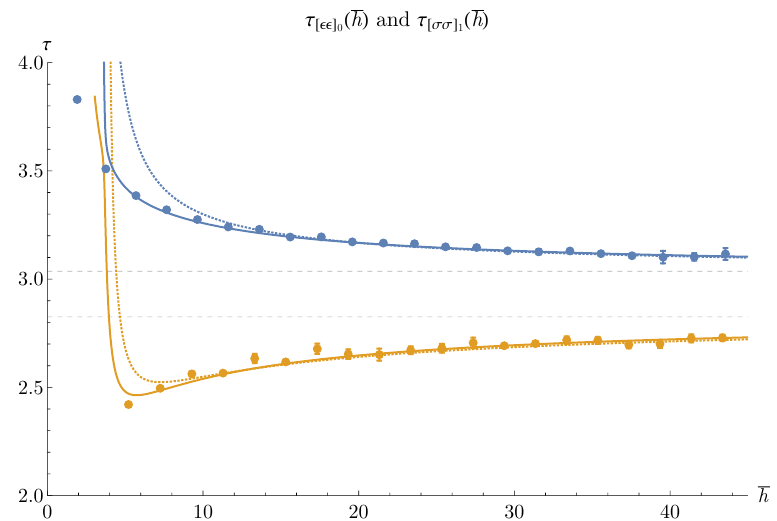
Figure 2. Twists of the double-twist families [ (cid:15)(cid:15) ] 0 (orange) and [ (cid:27)(cid:27) ] 1 (blue). Again, we plot (cid:28) = (cid:1) (cid:0) ‘ versus h = (cid:1)+ ‘ . The dots show estimates using the extremal functional method and the 2 numerical bootstrap. The curves are estimates using large-spin perturbation theory and the mixing procedure described in [10] and reviewed in section 4.4. The dashed curves illustrate the e(cid:11)ects of modifying the mixing procedure. Figure reproduced from [10].